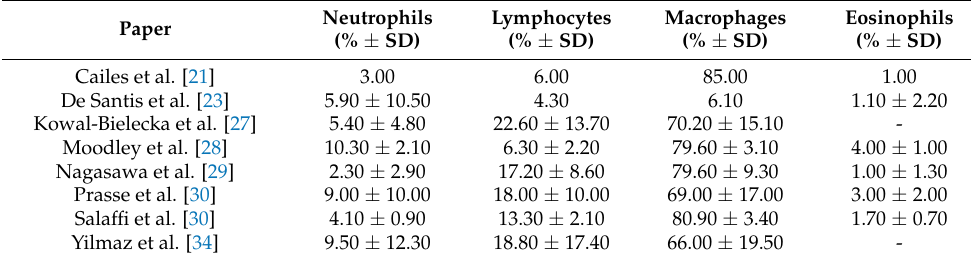
Table 2. Cellular percentages in BALF from SSc patients.